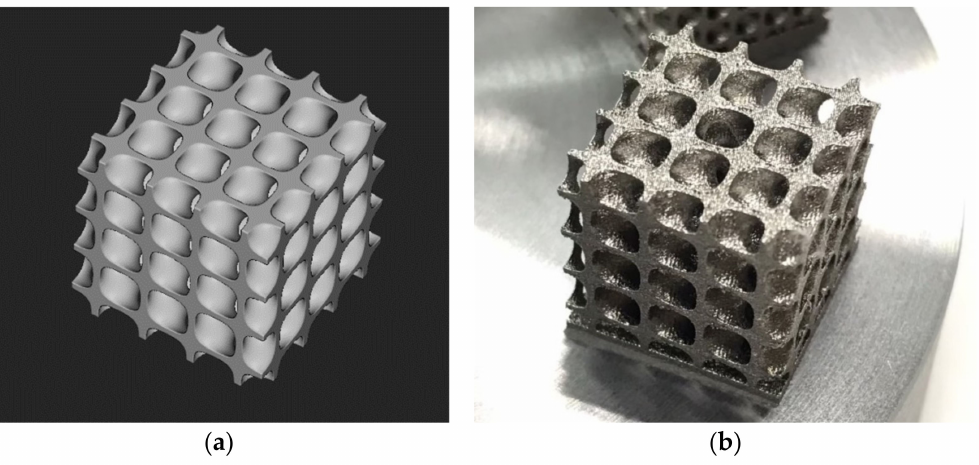
Figure 7. An example of TPMS structure: ( a ) generated by nTopology; ( b ) printed by Laser Powder Bed Fusion 3D